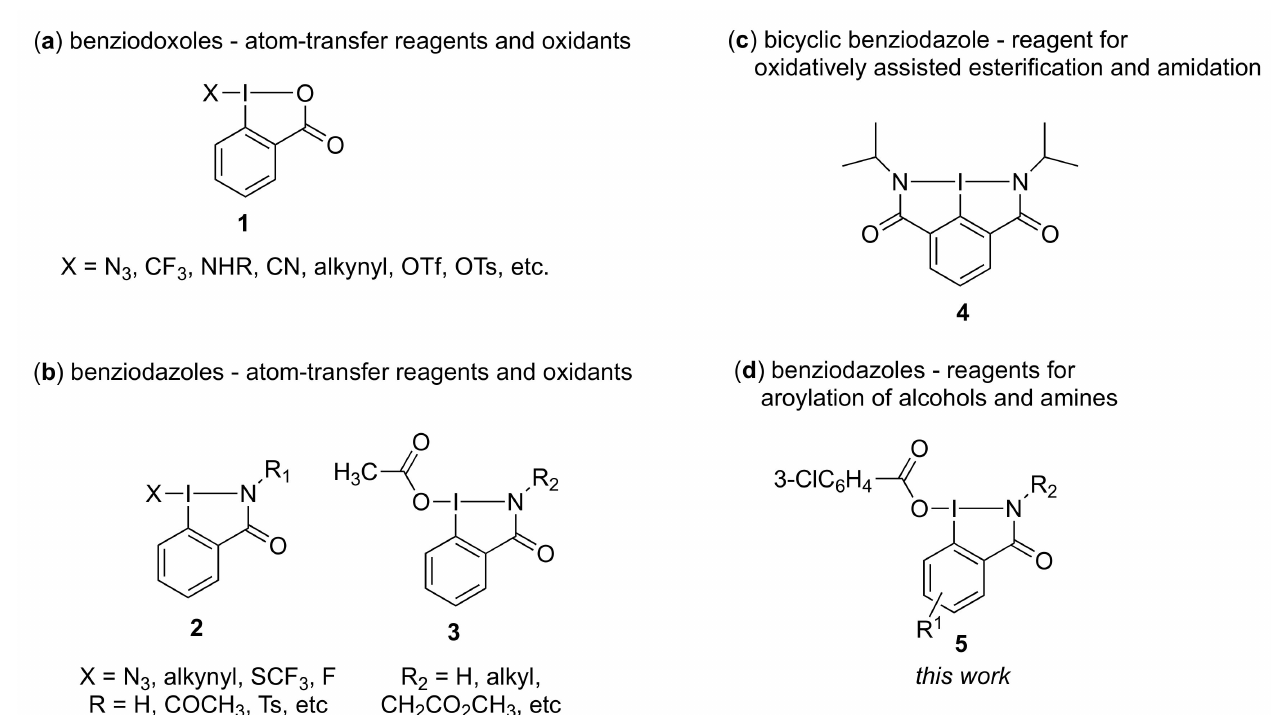
Figure 1. Important iodine(III)-containing heterocycles, benziodoxolones and benziodazolones. ( a ): benziodoxoles-atom transfer reagents and oxidants; ( b ): bicyclic benziodazole-reagent for oxidatively assisted esterification and amidation; ( c ): benziodazoles-atom-transfer reagent and oxidants; ( d ): benziodazoles-reagent for aroylation of alcohols and amides; 1 -benziodoxoles; 2 -bicyclic benziodazole; 3 , 4 -beniodazoles; 5